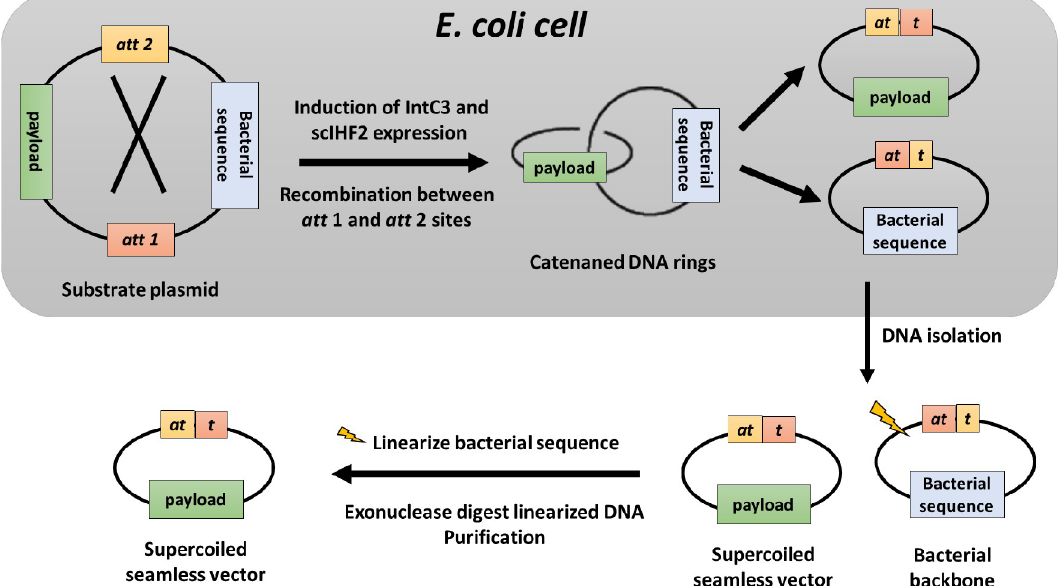
Fig 2. Outline of multi-scale seamless vector production using MG1655-ISC . See text for details. The catenated DNA rings generated by recombination inside E . coli are efficiently resolved into two monomeric DNA circles by topoisomerase IV. The DNA circles were purified from the E . coli strains and digested with an appropriate restriction enzyme to linearize the bacterial backbone and unrecombined substrate plasmid. This was followed by exonuclease treatment to digest the linear and nicked circular DNA products. Hence, only supercoiled seamless vector will be